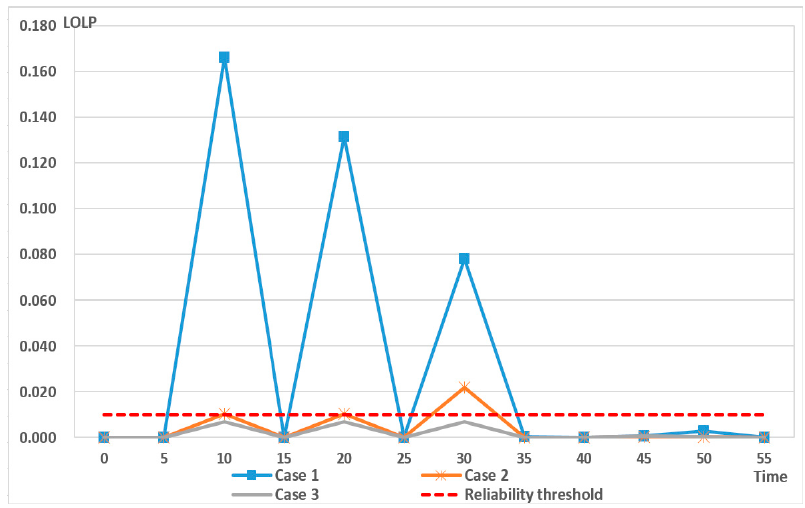
Figure 8. Hourly LOLP during a 1 h period.